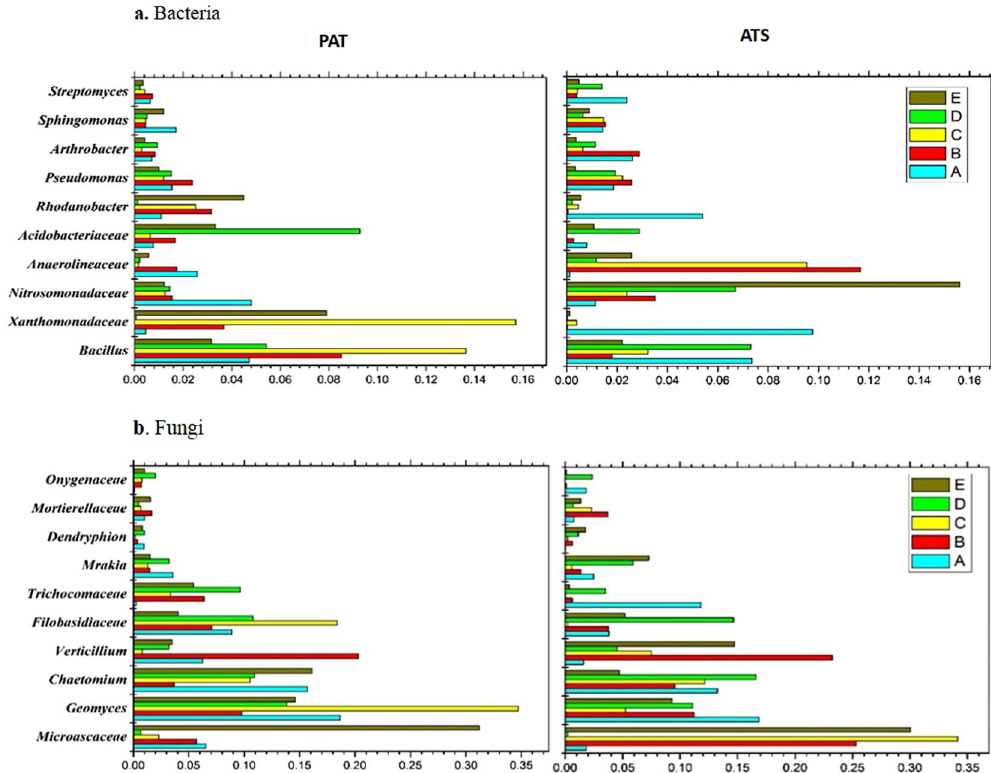
Figure 2. Relative abundances of the dominant bacterial ( a ) and fungal ( b ) groups in PAT and ATS rhizosphere soil. The “A”, “B”, “C”, “D” and “E” refers to the five sampling sites: Qixia, Muping, Laizhou, Huludao and Changli,